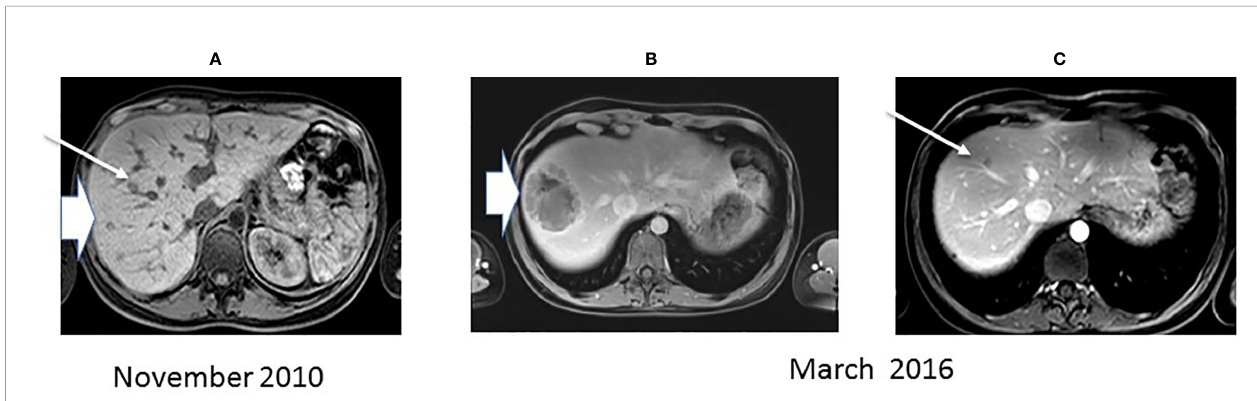
FIGURE 1 | MRI. MRI imaging of the liver in 2010 showing two minute tumors ( A one progressed (arrowhead) B ) in March 2016 while the other (thin arrow) (C) remained